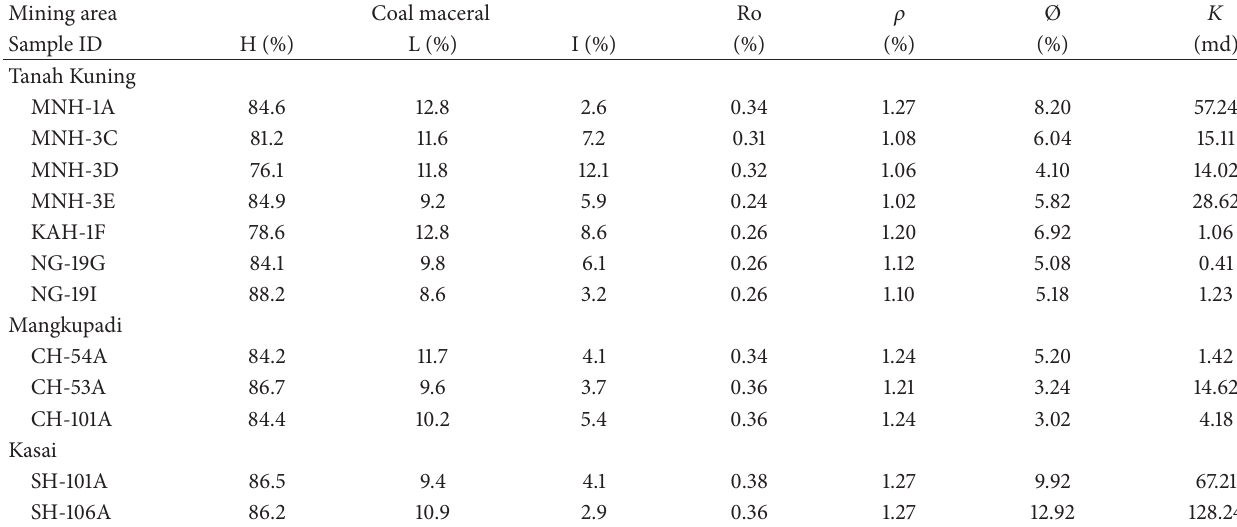
Table 1: Sajau coal characteristics, density, porosity, and